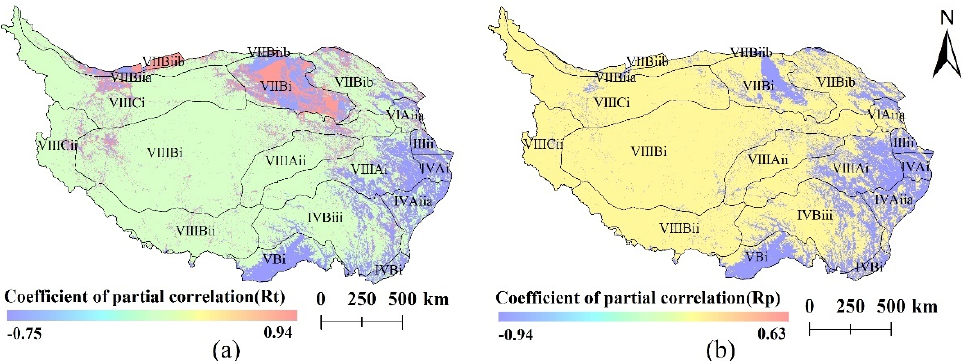
Figure 5. The coefficient of partial correlation between vegetation coverage and climate factors, ( a ) is the coefficient of partial correlation between vegetation coverage and average annual temperature, and ( b ) is the coefficient of partial correlation between vegetation coverage and annual precipitation.